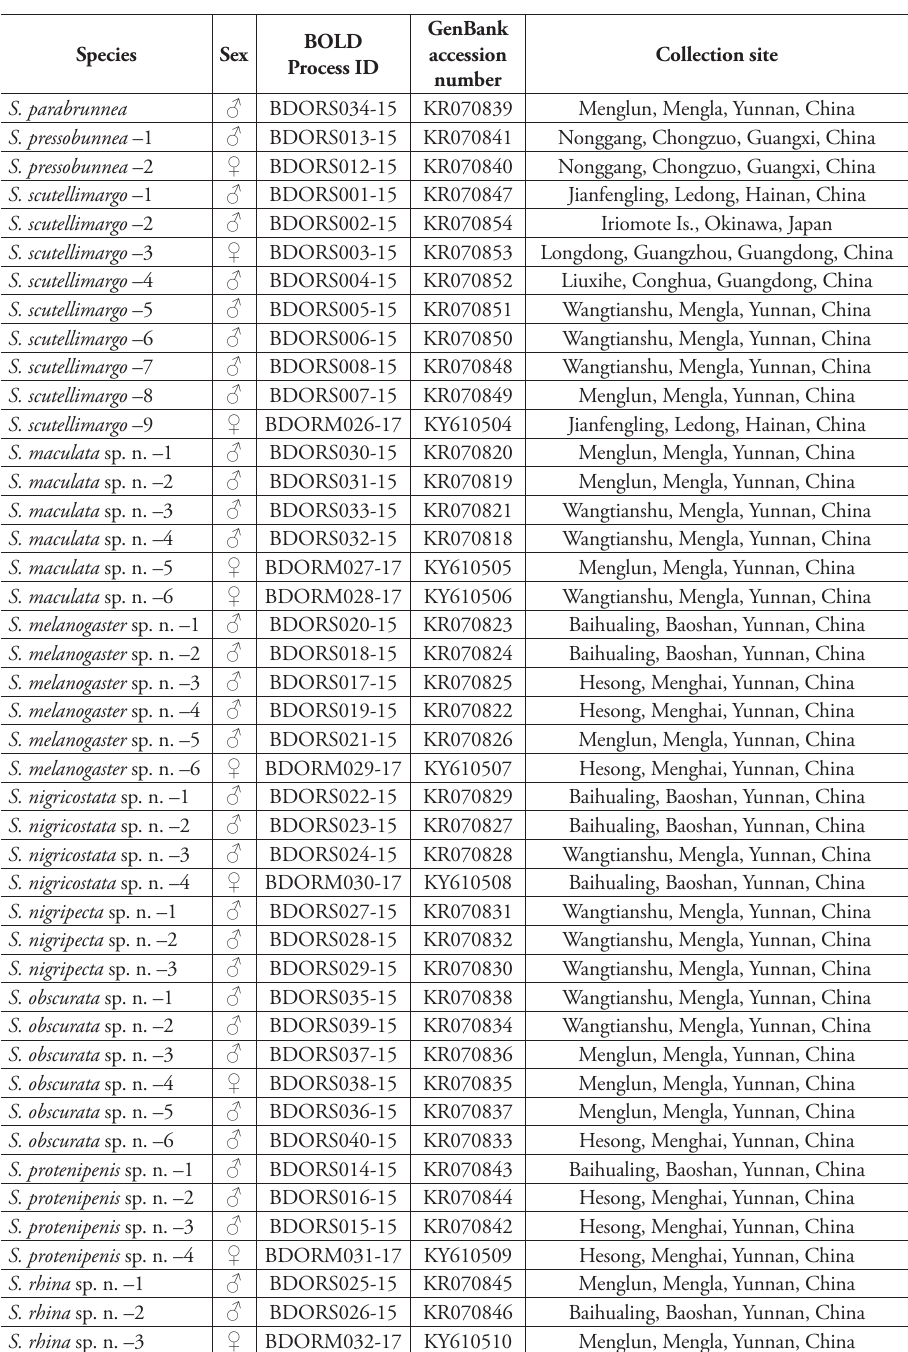
Table 1. Specimens of the brunnea group used for DNA barcoding. Species Sex